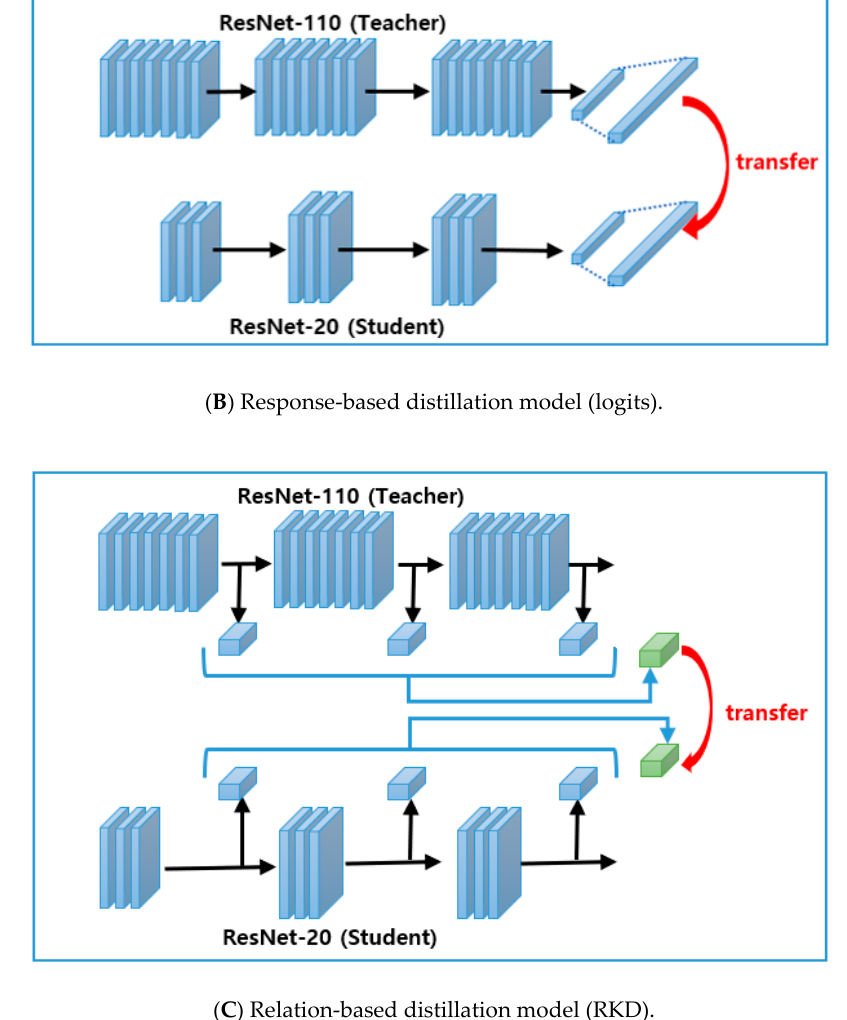
Figure 4. Three types of knowledge distillation models used in our ensemble model.